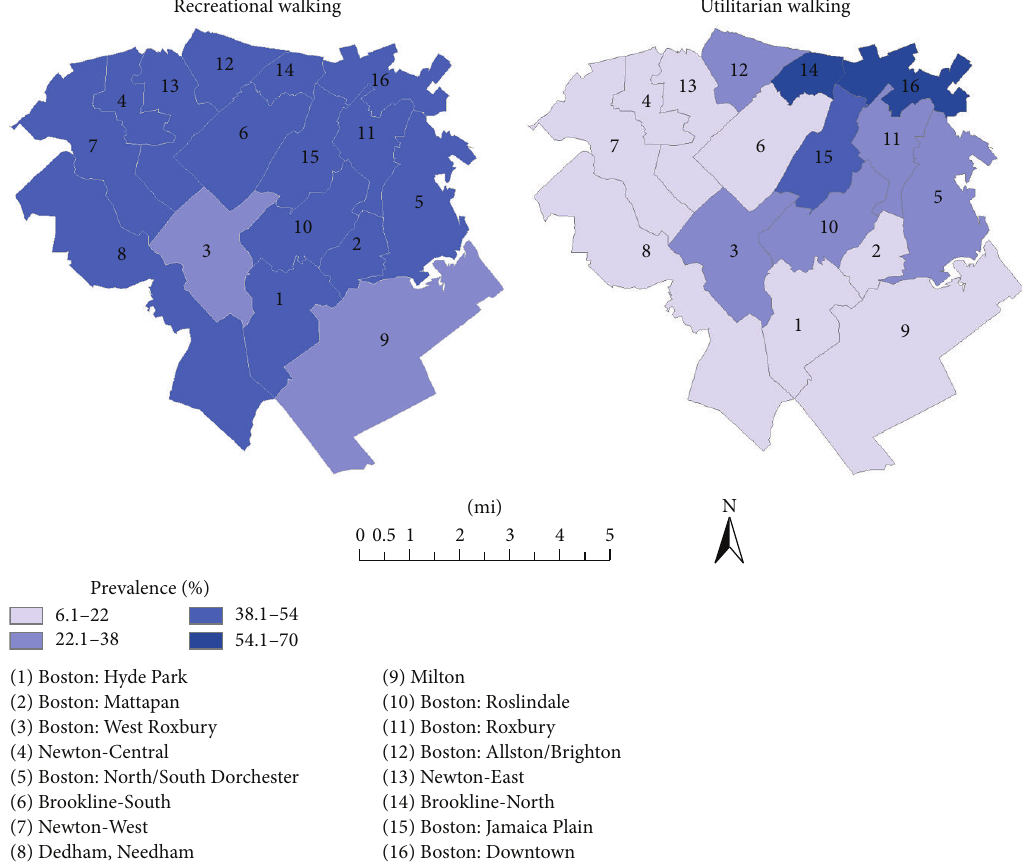
Figure 1: Community variations in prevalence of recreational and utilitarian